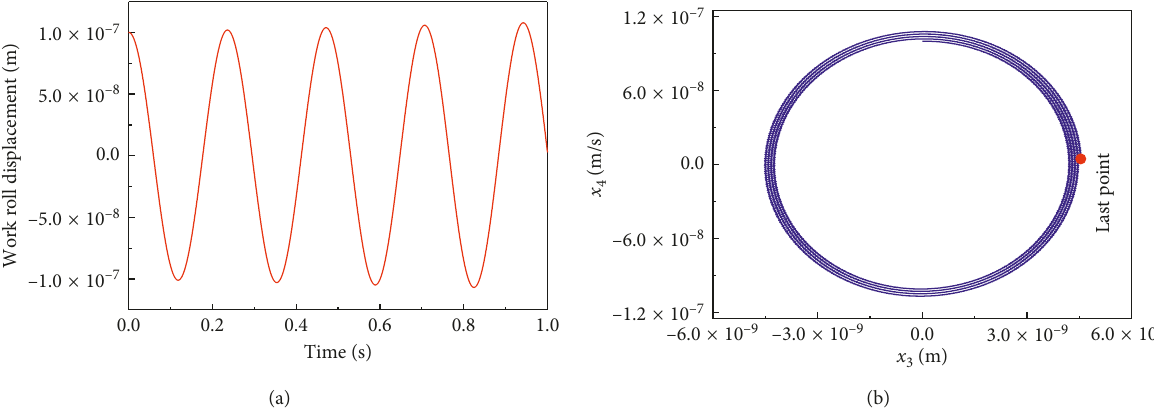
Figure 6: Dynamic response of the work roll displacement and the phase diagram under μ ∗ � 0 . 0048: (a) time history of work roll displacement; (b) phase diagram.